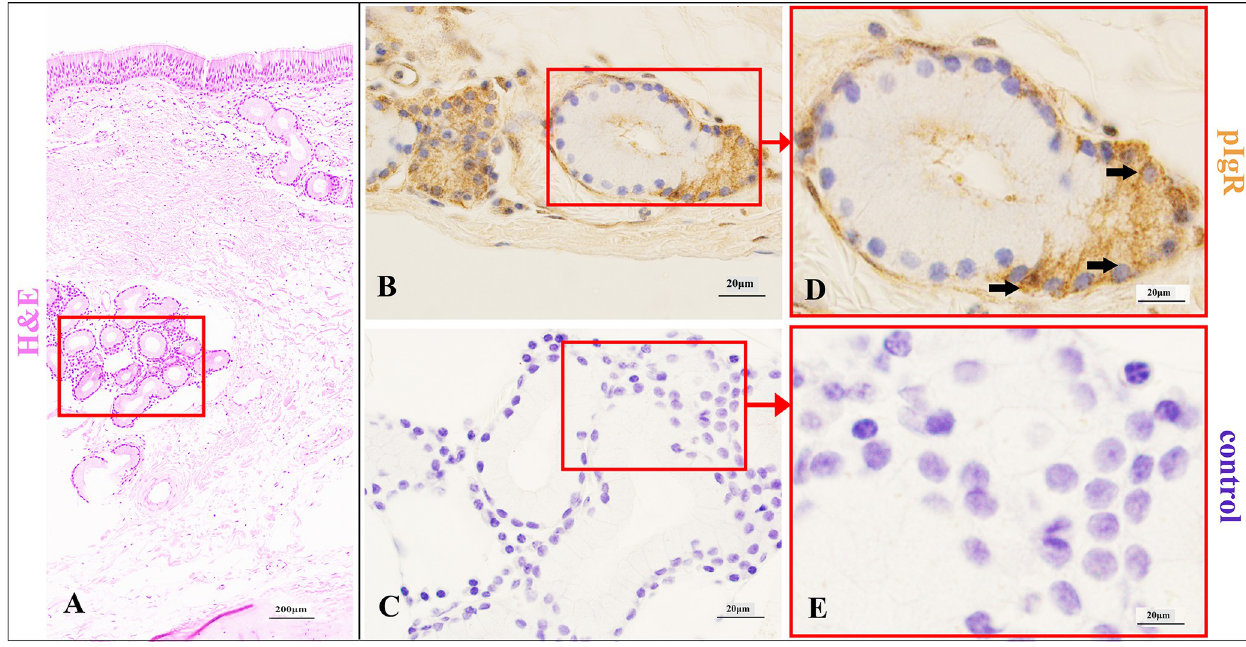
Fig 3. pIgR expression characteristics in the main bronchial glands of Bactrian